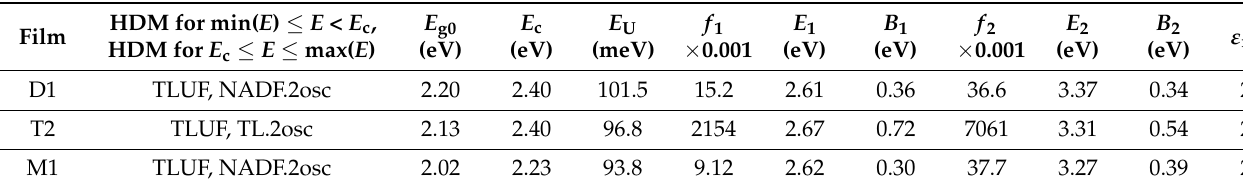
Table 1. Values of the parameters, determining n ( λ ) and k ( λ ) of the PAZO polymer films, obtained using HDM and T ( λ ). The dispersion models selected at stages 1 and 2 of HDM are described in the second column, whereby the symbol “.2osc” denotes that the respective DM employs two oscillators.